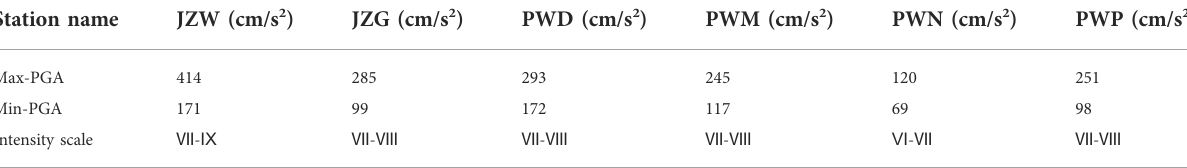
TABLE 6 Corresponding intensity range of six typical locations in the Chinese seismic intensity scale.